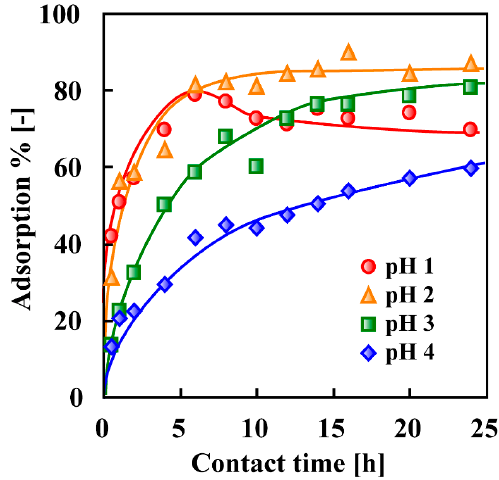
Figure 36. Temporal change in the % adsorption of Cr(VI) by crosslinked persimmon gel at different pH values at 30 °C . Initial Cr(VI) concentration = 13 mM, weight of gel = 10 mg, test solution volume = 10 mL [35]. (With permission for reuse from Elsevier B.V.).